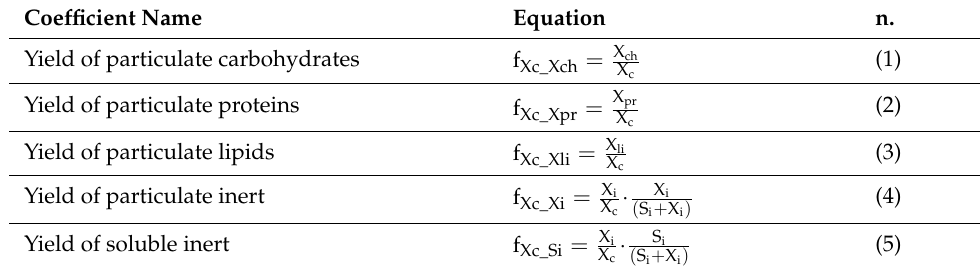
Table A3. Computation of yields from disintegration of complex